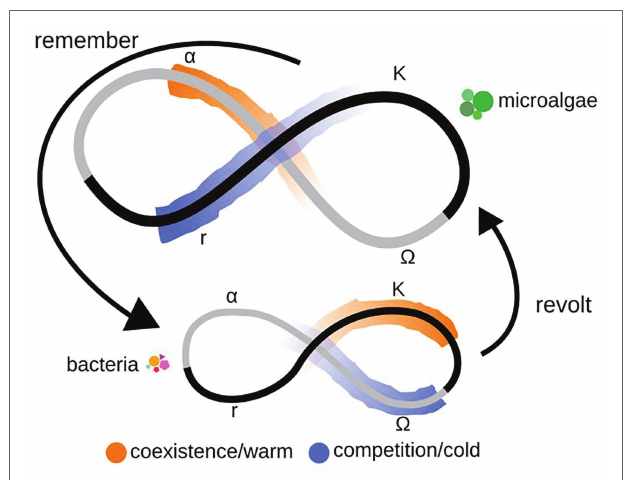
FIGURE 10 | An illustration of adaptive cycles and the concept of panarchy, used to describe the interactions between the microalgae (upper level) and bacteria (lower level), going from coexistence during the warmer (orange) temperature regime to competition during the colder (blue) temperature regime. r – growth phase, K – conservation phase, Ω – release phase, and α – adaptation phase. Remember – impact on lower level by upper level, revolt – influence from lower level on upper